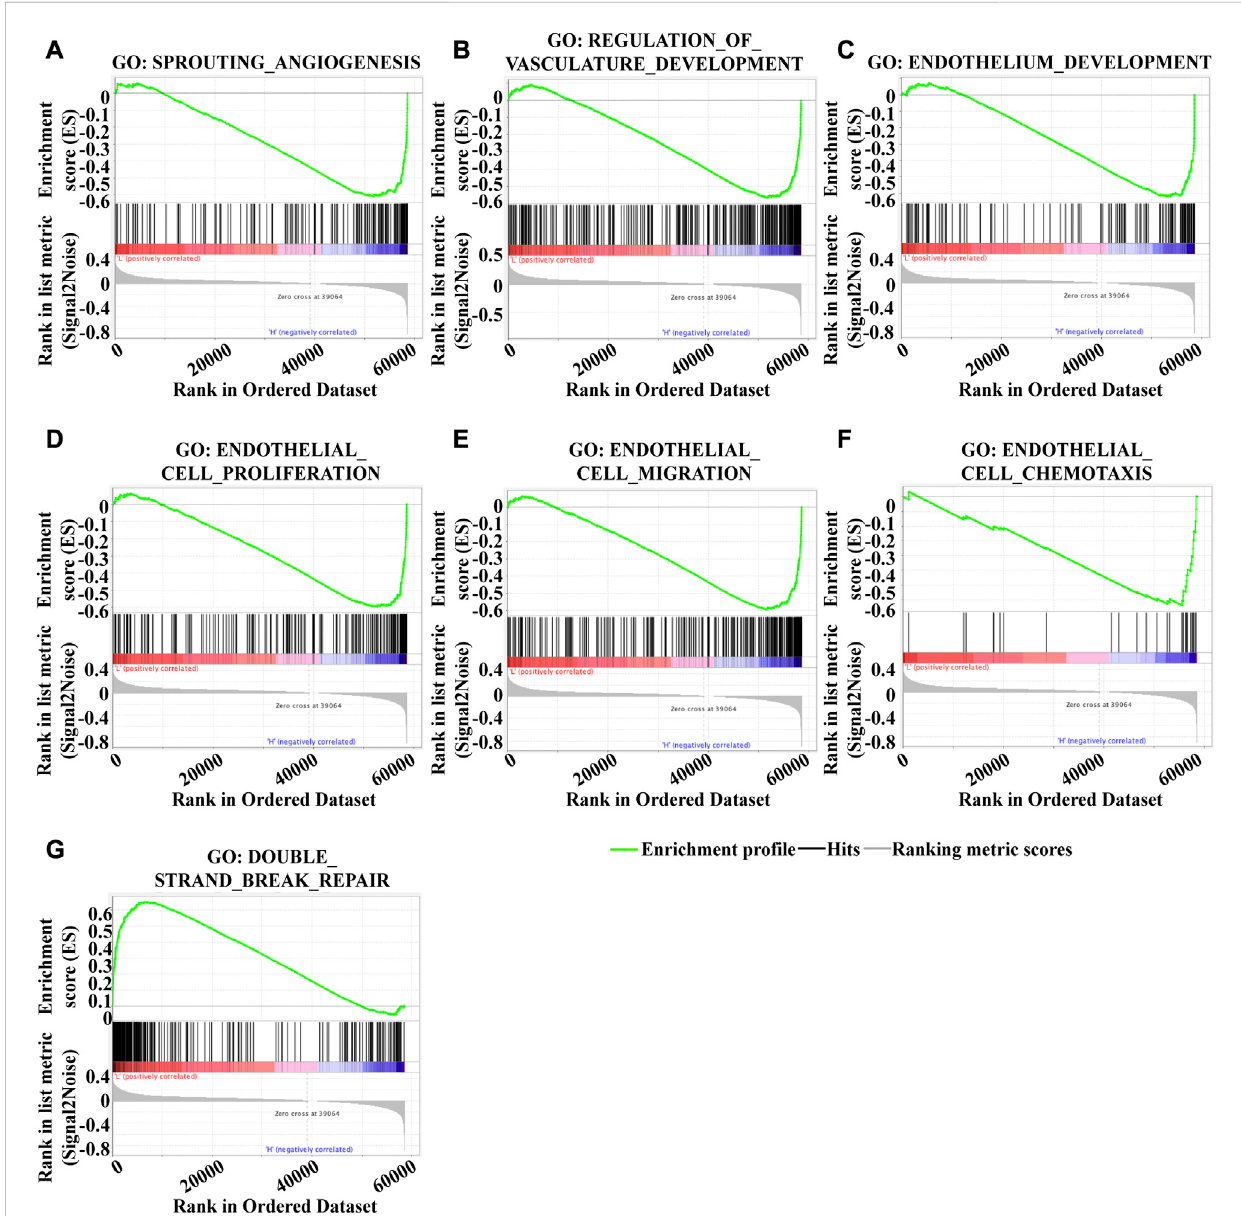
FIGURE 6 Gene set enrichment analysis of GO analysis. Sprouting _angiogenesis (A) , Regulation_of_vasculature_development (B) , Endothelium_ development (C) , Endothelial_cell_proliferation (D) , Endothelial_cell_migration (E) , Endothelial_cell_chemotaxis (F) , and Double_strand_break_ repair (G)